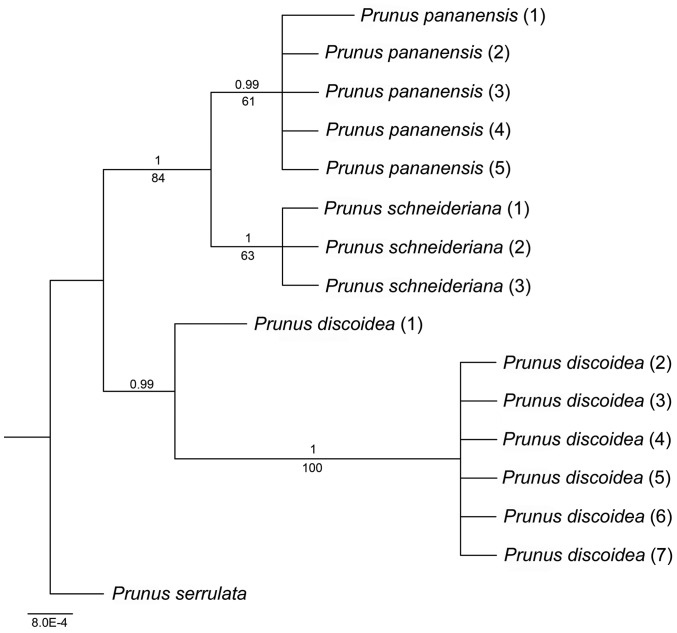
Majority consensus tree infered from Bayesian analysis based on the atpB-rbcL and trnL-F data.Numbers above the branches are posterior probabilities (PP≥50%); numbers below the branches are maximum parsimony bootstrap percentage (BS≥50%).